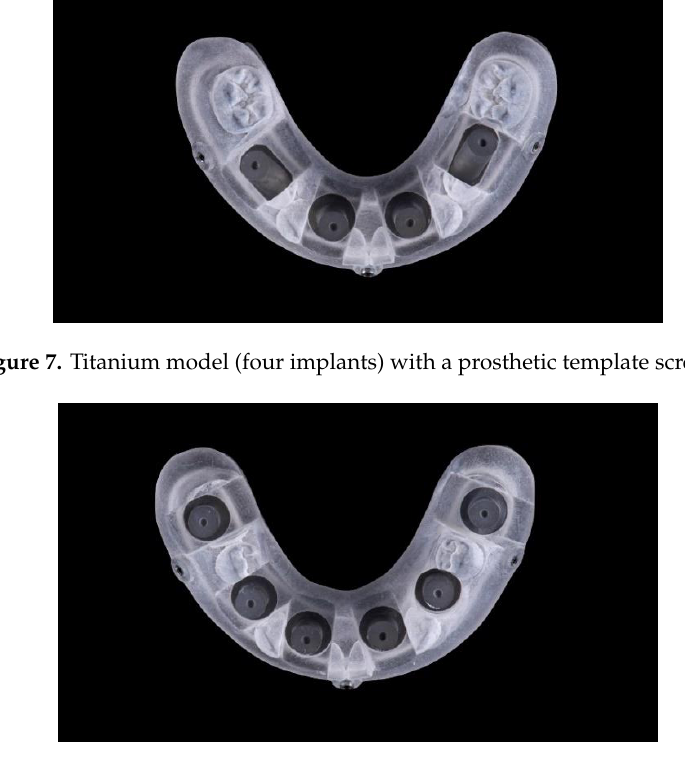
Figure 8. Titanium model (six implants) with a prosthetic template screwed.